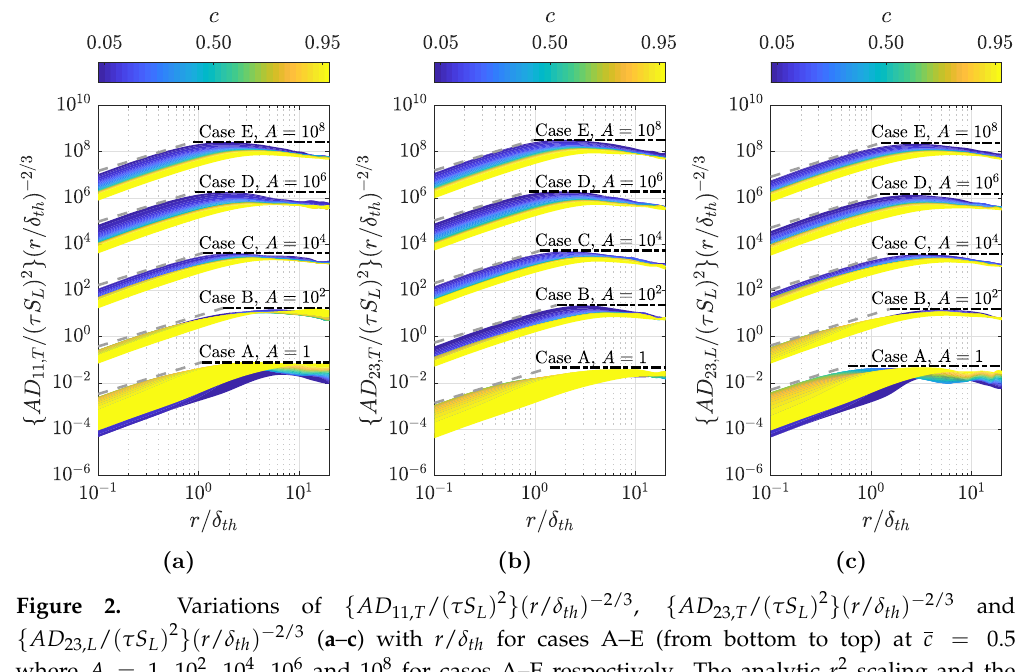
( r / δ th ) − 2/3 , ( r / δ th ) − 2/3 and AD 11, T / ( τ S L ) 2 AD 23, T / ( τ S L ) 2 Figure 2. Variations of { } { } ( r / δ th ) − 2/3 ( a – c ) with r / δ th for cases A–E (from bottom to top) at c = 0.5 AD 23, L / ( τ S L ) 2 { } where A = 1, 10 2 , 10 4 , 10 6 and 10 8 for cases A–E respectively. The analytic r 2 scaling and the Kolmogorov scaling r 2/3 are shown by grey dashed lines and black dash-dot lines respectively and the constants of proportionality used for these lines are shown in Figure 5. The colour bar indicates the ) in question for the given value of c . The coefficient A is values of c for one of the points (i.e., x B or x B (cid:48) introduced for the convenience of